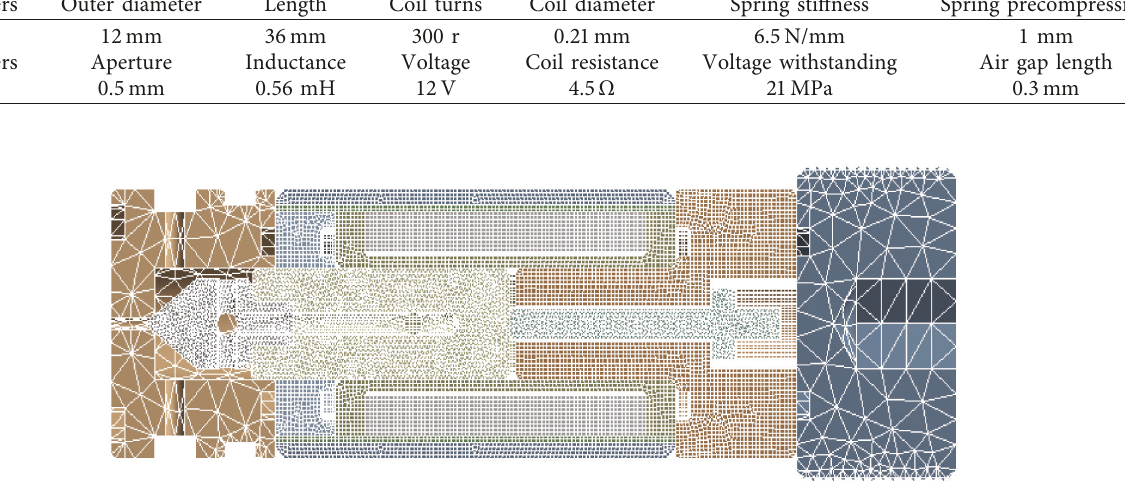
Figure 5: Grid generation of the digital